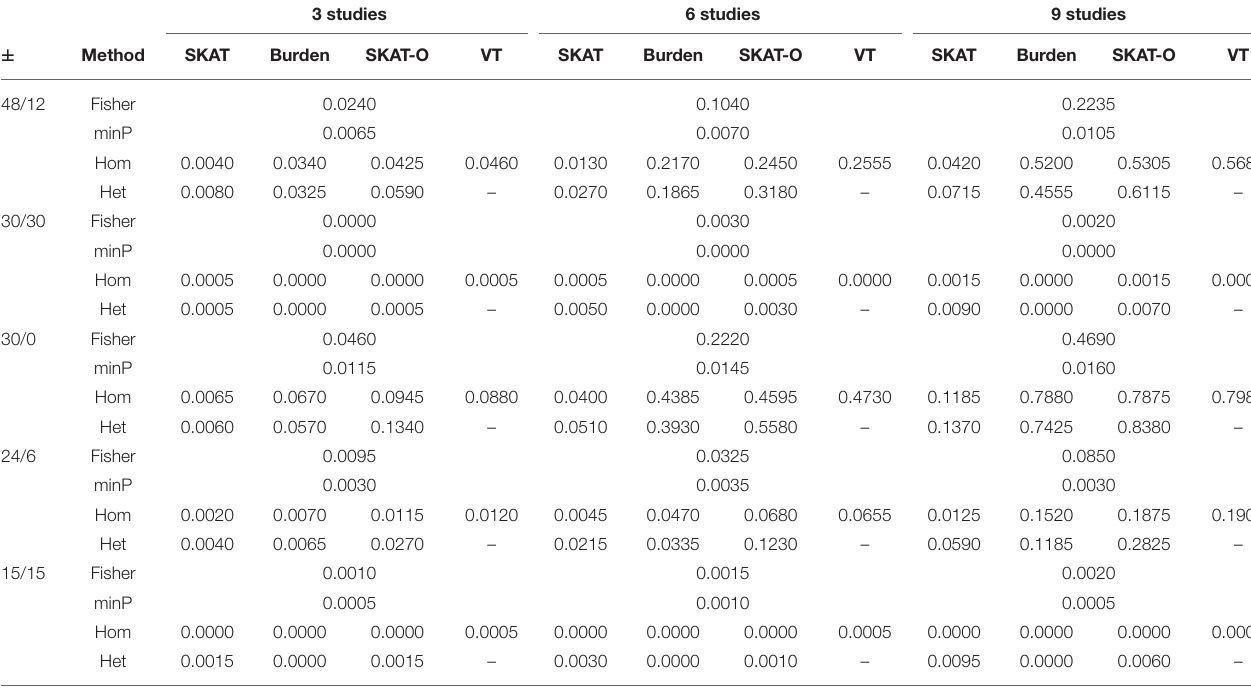
TABLE 3 | Empirical power estimates for dichotomous phenotype for heterogeneous variants among studies.